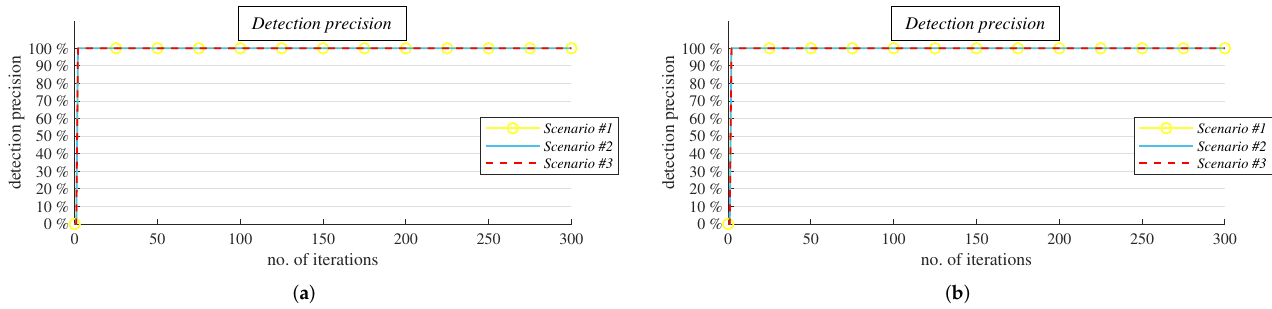
Figure 17. Evaluation of detection precision of proposed mechanism in random geometric graphs with various connectivity under three scenarios. ( a ) Densely connected random geometric graphs. ( b ) Sparsely connected random geometric graphs.